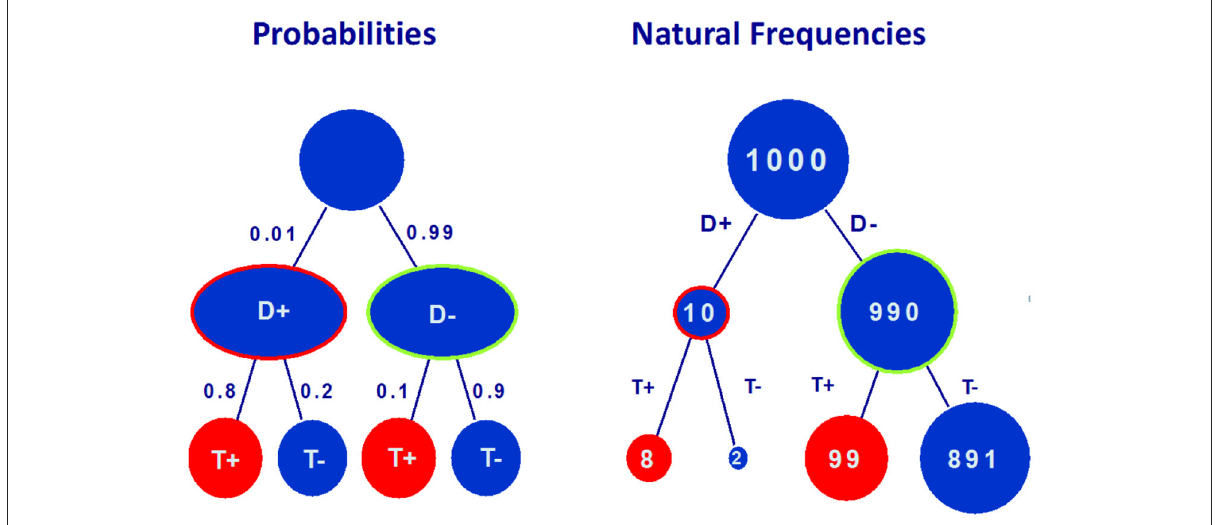
FIGURE2 The tree on the left hand side represents information about base rate of the diesease (P(D + ) = 0.01), sensitivity of the test P(T + |D + ) = 0.8, probability of false negatives (P(T-|D + ) = 0.2), probability of false positives (P(T + |D-) = 0.1) and specificity (P(T-|D-) = 0.9). The tree on the right hand side represents the corresponding natural frequencies for a random sample of 1,000